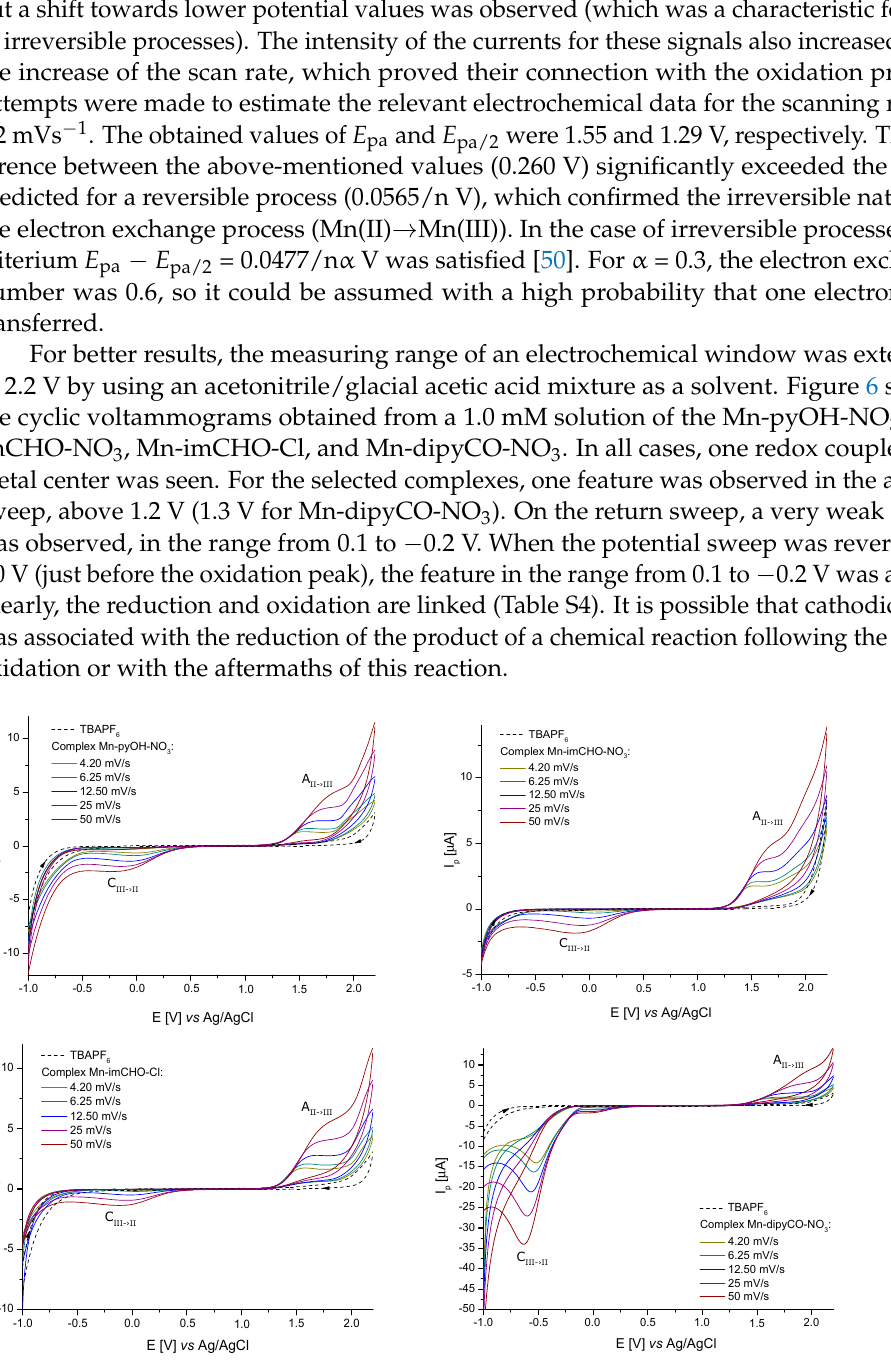
Figure 6. Cyclic voltammograms of the Mn-pyOH-NO 3 , Mn-imCHO-NO 3 , Mn-imCHO-Cl, and Mn-dipyCO-NO 3 recorded at scan rates from 4.20 to 50 mV s − 1 in CH 3 CN/glacial CH 3 COOH solution containing 0.1 M TBAPF 6 (CV conditions: BDDE, Ø = 3 mm, T = 25° C). Concluding, the anodic peak potentials related to the oxidation of the Mn(II)/Mn(III) increase in the following order for the manganese complexes: Mn-imCHO-NO 3 < Mn- pyOH-NO 3 < Mn-imCHO-Cl < Mn-dipyCO-NO 3 (Figure 7; at scan rate 6.25 mVs − 1 ). Thus, the presented row indicates a decrease in the reducing properties for the tested Mn(II) complexes. Thereby, the oxidation efficiency of the Mn(II) complexes results from the row mentioned above.